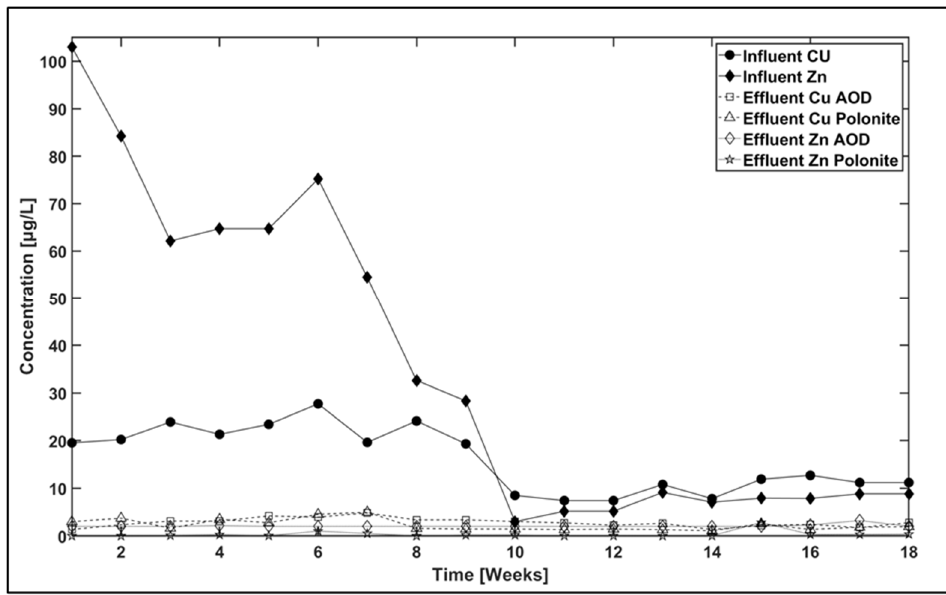
Figure 3. Temporal changes in dissolved influent and effluent Cu and Zn concentrations in the PBR experiment.